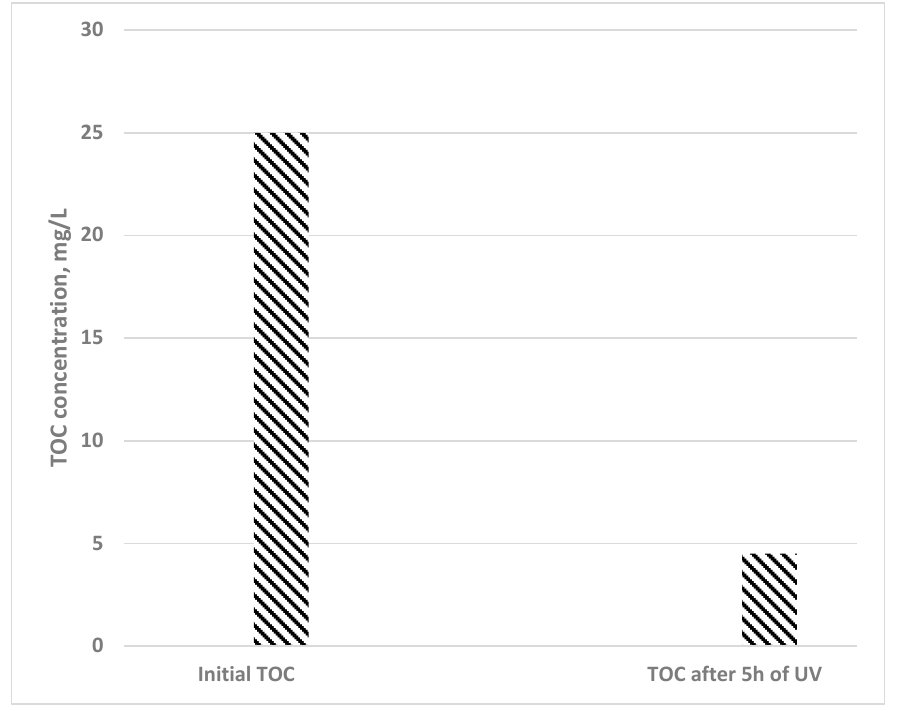
Figure 14. TOC values before the reaction and after 5 h of illumination with the involvement of CuFe 2 O 4 -70%/rGO/HNT.